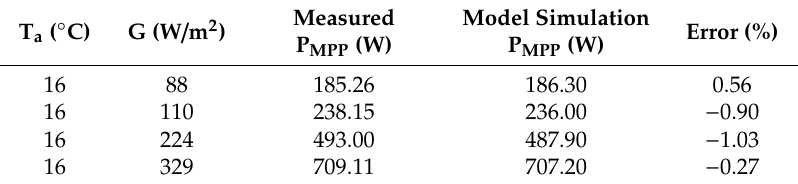
Table 2. System 1 experimental